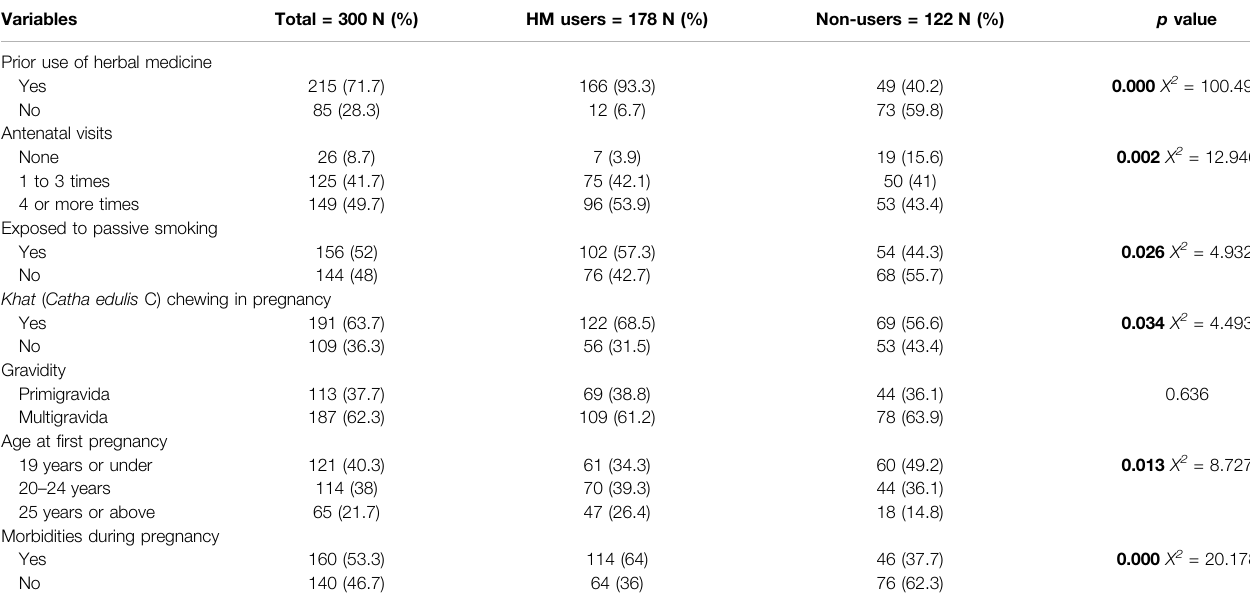
TABLE 2 | Medical characteristics of